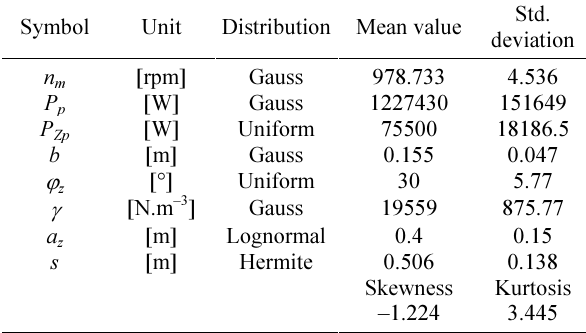
Table 3. Random variables for the second terrace